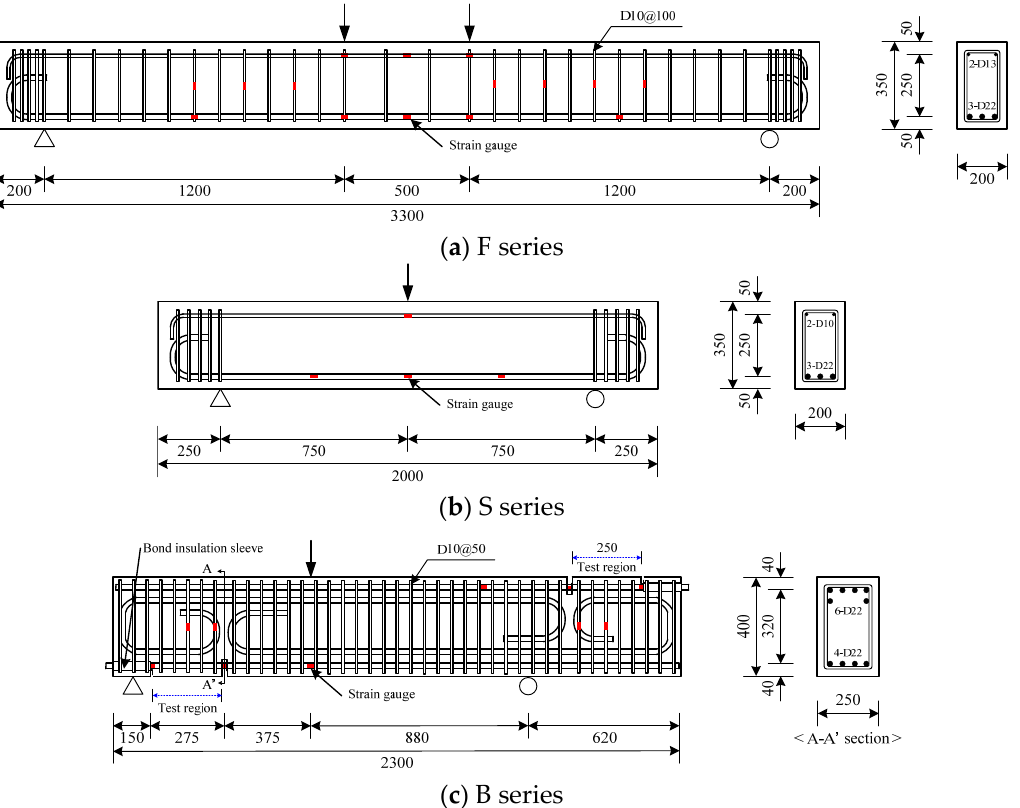
Figure 3. Details of specimen (unit: mm).